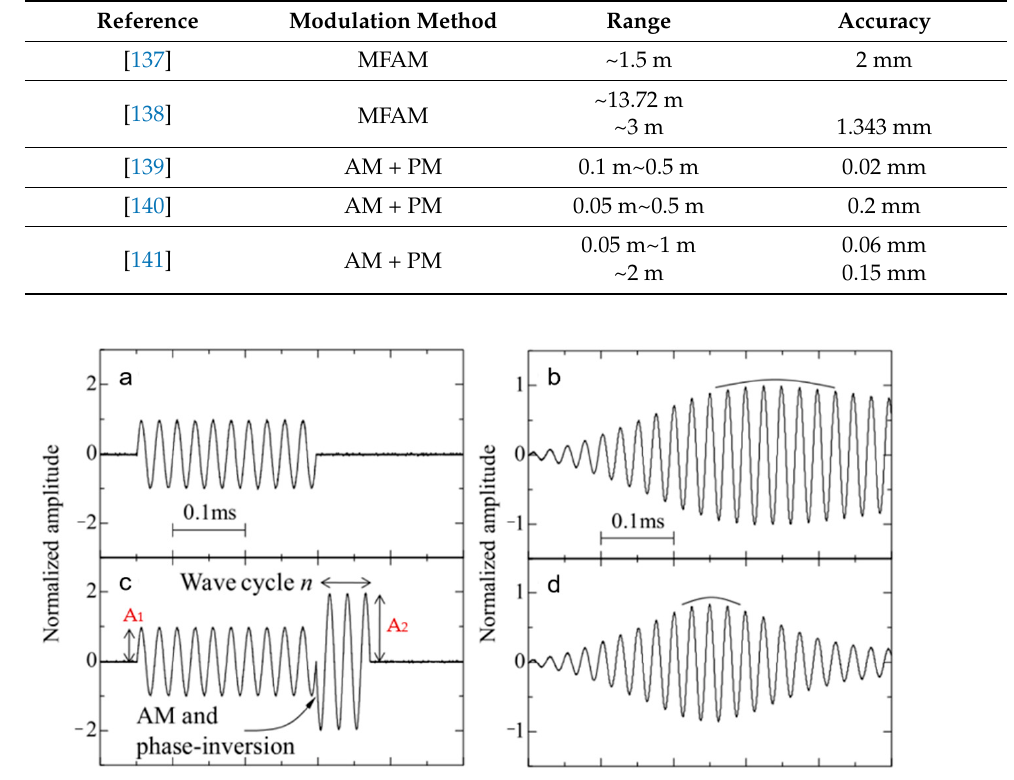
Table 6. Performance comparison of several AM based ranging systems.